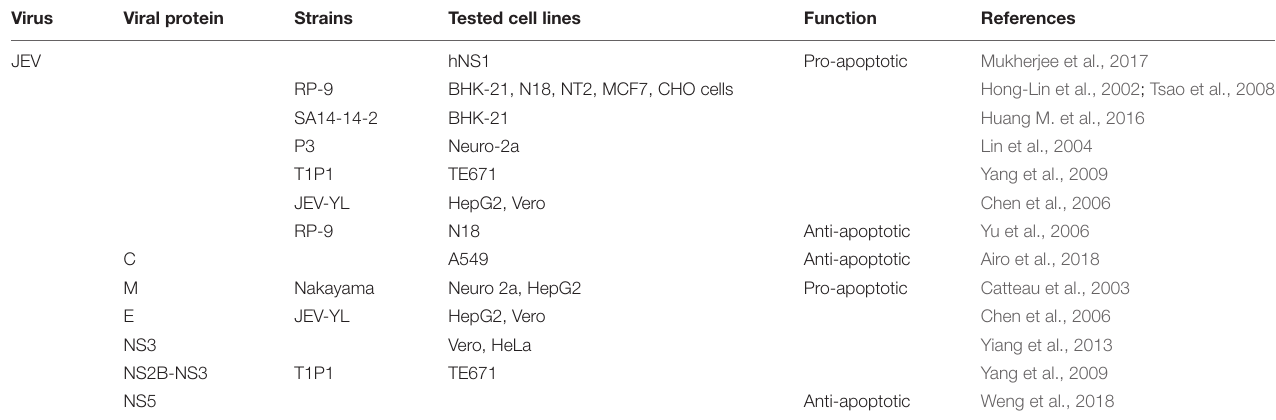
TABLE 3 | Pro-apoptotic or anti-apoptotic activity of JEV and its proteins. Virus Viral